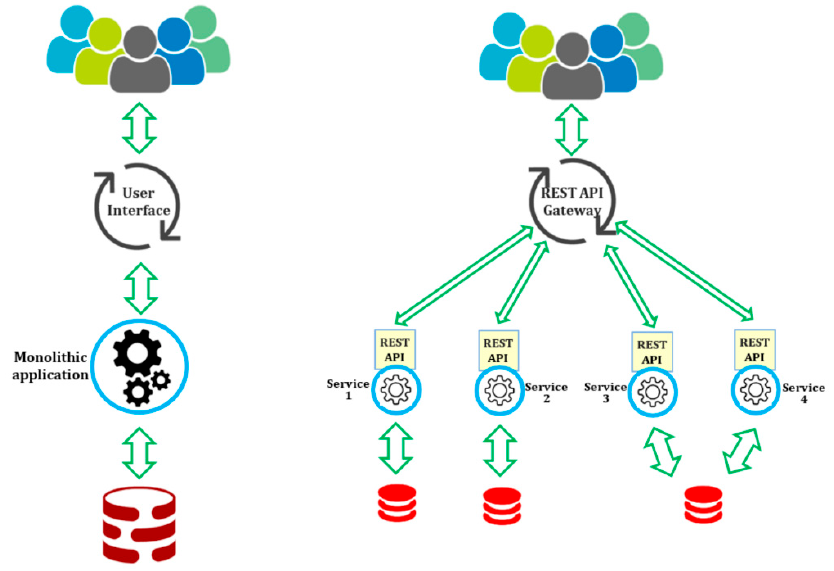
Figure 1. Applications structure of monolithic versus Microservices architecture.